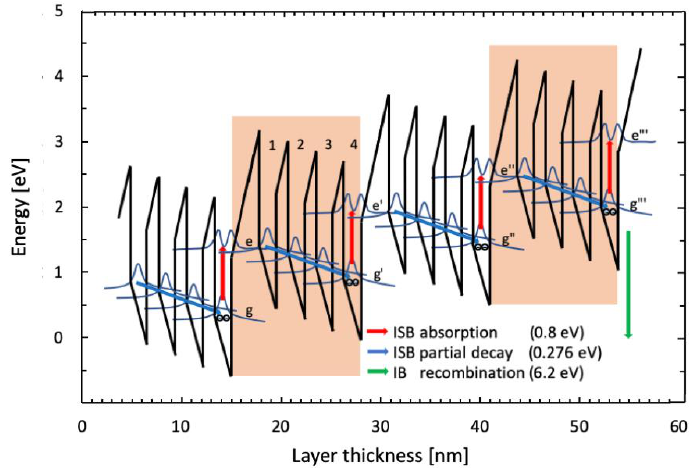
Figure 3. Conduction band structure under an applied bias voltage of 6.2 V on 12 periods—corresponding to an electric field of 413 kV/cm. QWs/barriers 1, 2, 3, 4 correspond to one SL period. Excitation through photon absorption (vertical red arrows) and partial relaxation (oblique blue arrows) are schematically shown. The vertical transition energy in the main QW measures 800 meV ( λ = 1.55 µm). The green arrow marks the interband transition in the deep-UV.